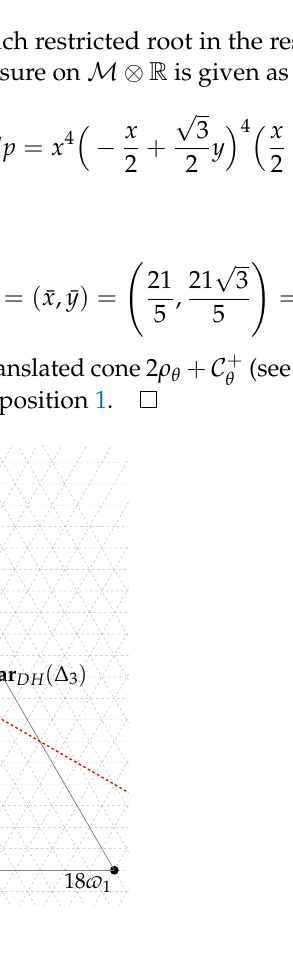
Figure 3. ∆ 3 = ∆ ( X 3 , K − 1